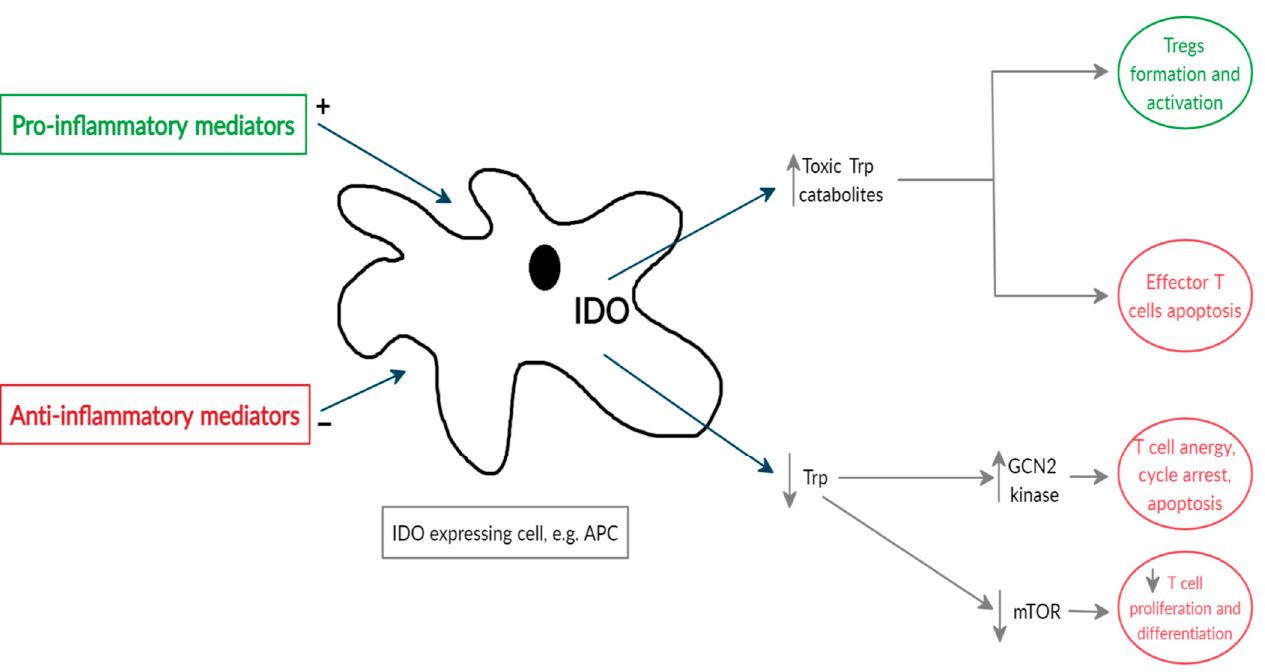
Figure 2. Simplified scheme of IDO activity in immune regulation. IDO is expressed in various cells, such as APCs, fibroblasts, endothelial, epithelial, smooth muscle cells, etc., in response to proinflammatory mediators. Due to IDO activity, decreased levels of tryptophan activate the GCN2 kinase, which leads to T-cell anergy, T-cell cycle arrest and apoptosis. The deactivated mTOR pathway results in suppressed T-cell proliferation and differentiation. Increased levels of toxic tryptophan ‐ kynurenine pathway metabolites induce effector T ‐ cell apoptosis and promote Treg formation and activation.